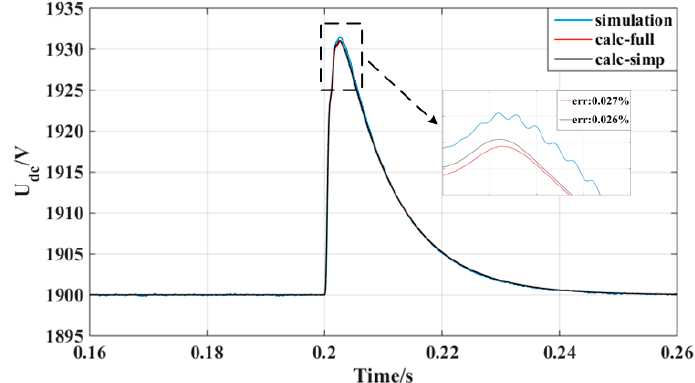
Figure 8. The waveform of input dc bus voltage (power inversion).